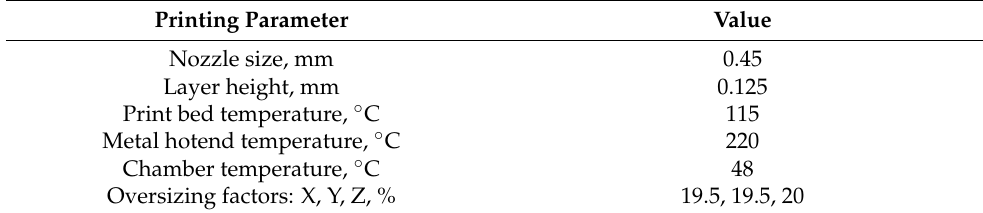
Table 3. Printing settings for the Markforged 17-4 PH